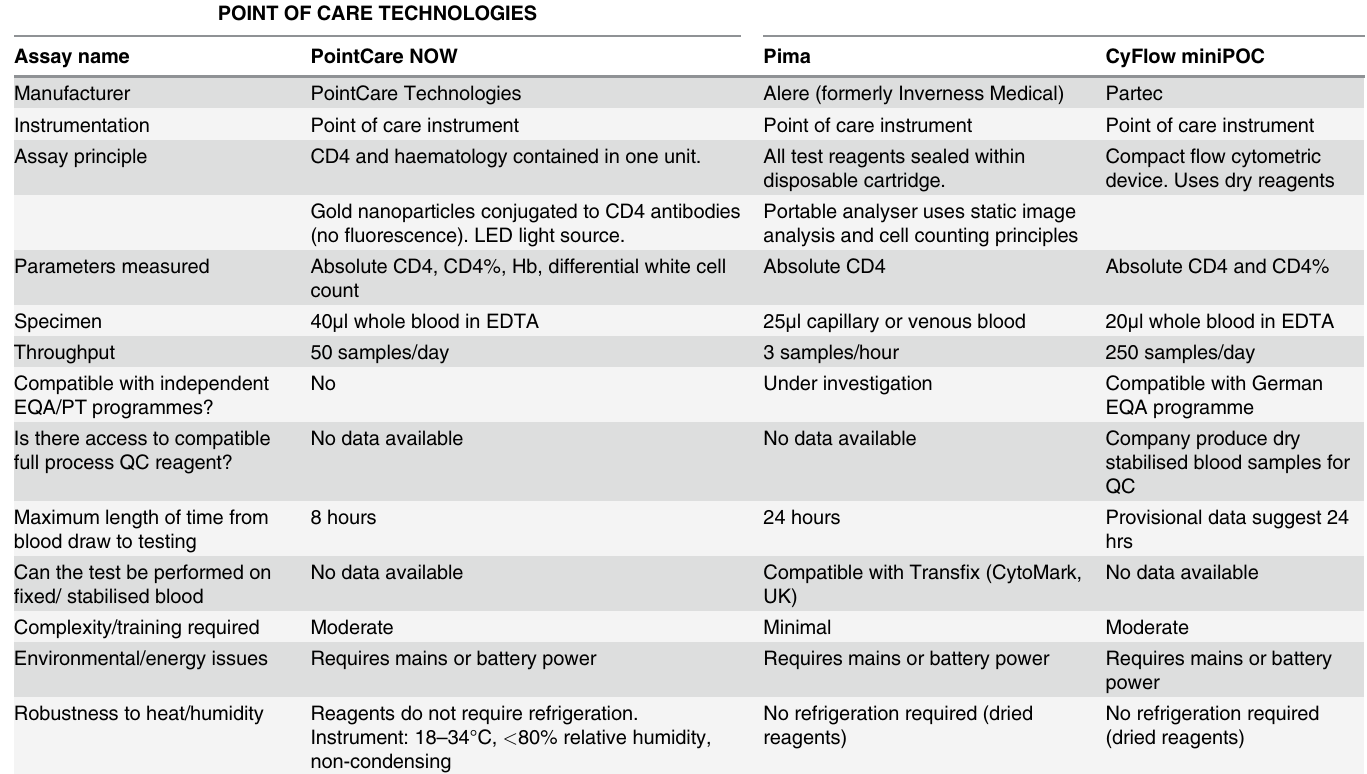
Table 5. Operating characteristics of Point of Care (POC) technologies for CD4+ T-cell enumeration. POINT OF CARE